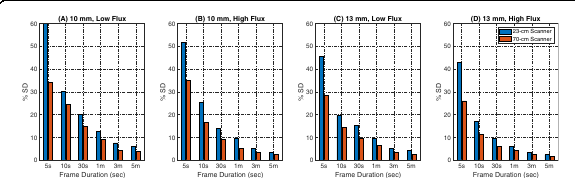
Fig. 2 (abstract A21). Percent standard deviation across 20 replicates of activity uptake in four lesions when simulated on the 23-cm and 70-cm scanners. 13-mm spheres (C, D) show improved precision compared to 10 mm spheres (A, B) and high flux lesions (B, D) show improved precision when compared to low flux (A, C) lesions. Precision data is grouped by frame duration, where there